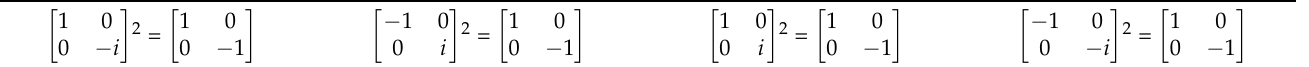
Table 3. Self-products for the original (reinterpreted) Chomsky